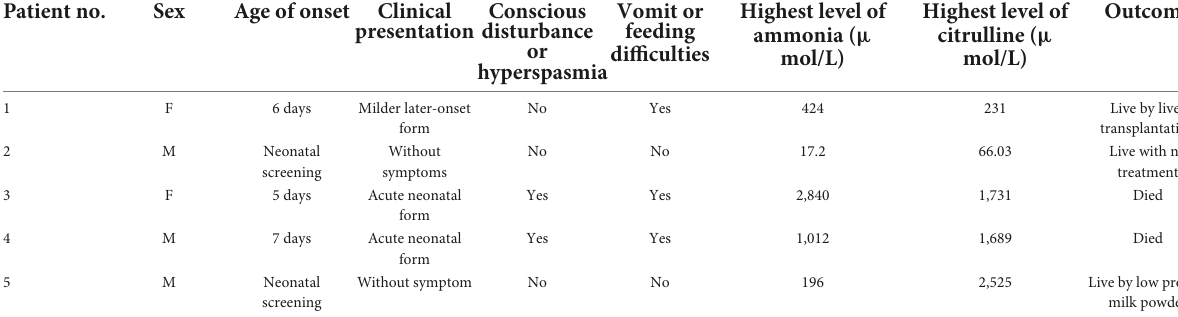
TABLE 1 Clinical, laboratory data, and outcomes of the five patients. Patient no.